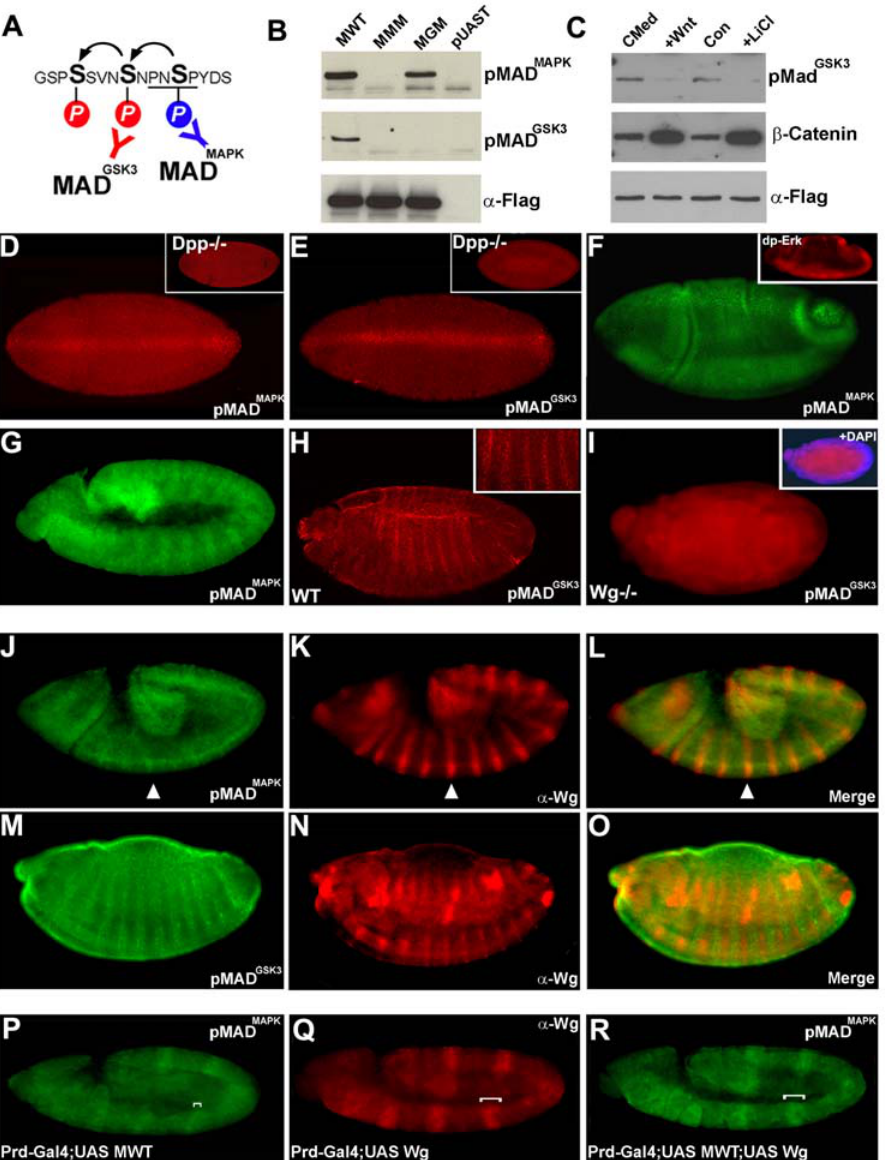
Figure 3. Phospho-Specific Antibodies Reveal Wg-regulated Segmental Expression Patterns of pMad MAPK and pMad GSK3 . (A and B) Western blot analysis of pMad MAPK and pMad GSK3 antibodies demonstrating that they were phospho-specific, and that GSK3 phosphorylation had an absolute requirement for MAPK priming. Drosophila S2 cells were transiently transfected with the plasmids indicated. (C) Cultured 293T cells stably transfected with Mad-Flag treated with L-cell control conditioned medium (CMed), Wnt3a medium, control DMEM (Con), or 30 mM LiCl in DMEM for 2 hours. Wnt3a and LiCl inhibited the Mad GSK3 phosphorylation band and increased b -Catenin levels (indicating that the Wnt treatment was effective). (D and E) pMad MAPK and pMad GSK3 antibodies stain the entire blastoderm and a Dpp-dependent dorsal stripe (inset). (F) pMad MAPK tracks ventral EGFR-activated MAPK (inset shows diphospho-Erk staining). (G and H) Segmental staining of pMad MAPK (Stage 9) and pMad GSK3 (Stage 17). (I) In Wg null mutants segmental expression is lost. Mutant embryos were identified by lack of staining with Wg antibody. Inset shows same embryo stained with DAPI to indicate that, despite its abnormal shape, it reached late stages of development. (J–L) Wg stabilizes pMad MAPK , overlapping with Wg stripes. (M–O) Nuclear pMad GSK3 accumulates in between Wg stripes, indicating that Wg inhibits Mad phosphorylation at GSK3 sites in vivo. (P–R) Wg overexpression driven with prd-Gal4 stabilizes pMad MAPK over a broader domain compared to just MWT alone (compare brackets in P and R). This experiment shows that Wg expression stabilizes pMAD MAPK